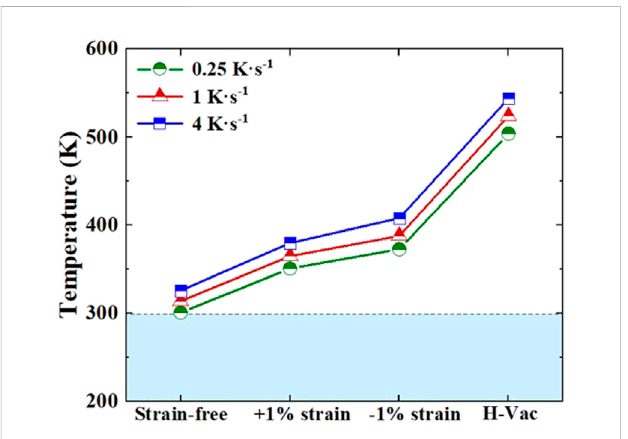
FIGURE 6 The calculated desorption temperature (with maximum release rate) of H from “ in fi nite ” H platelets in W with and without uniaxial strain. For comparison, the desorption temperature of H from mono-vacancy is also